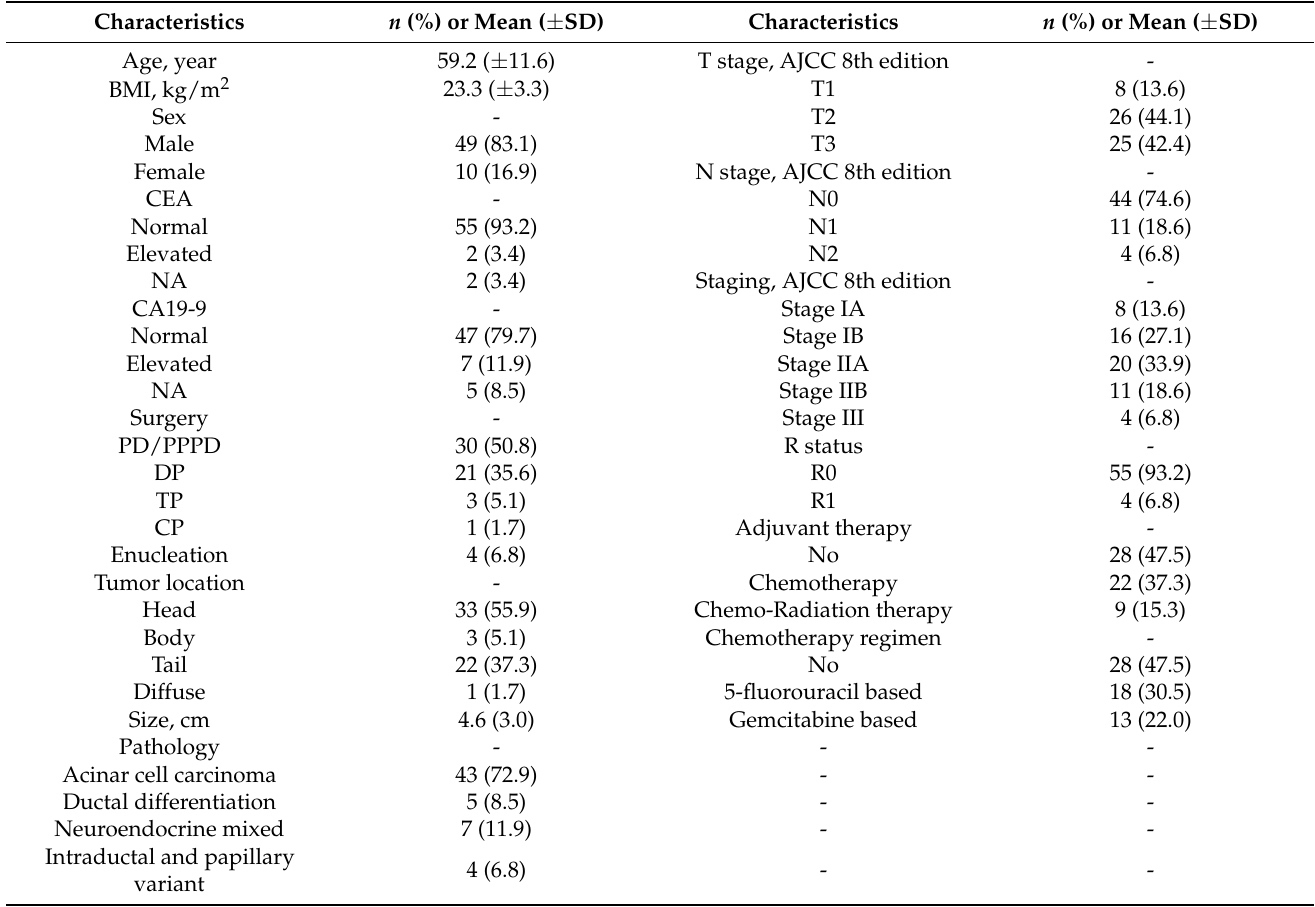
Table 1. Characteristics of patients ( n =